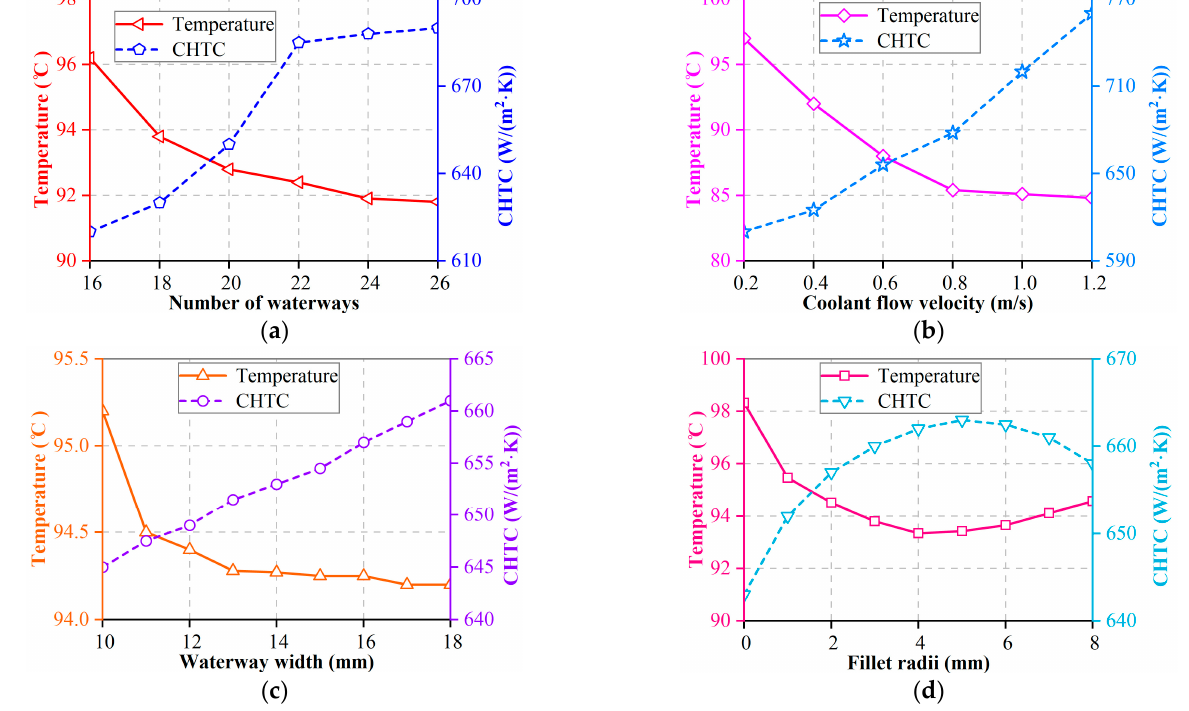
Figure 13. Stator peak temperature and CHTC vary with waterway structure parameters: ( a ) Number of waterways; ( b ) flow velocity; ( c ) Section width of waterway; ( d ) Fillet radii of U-type.